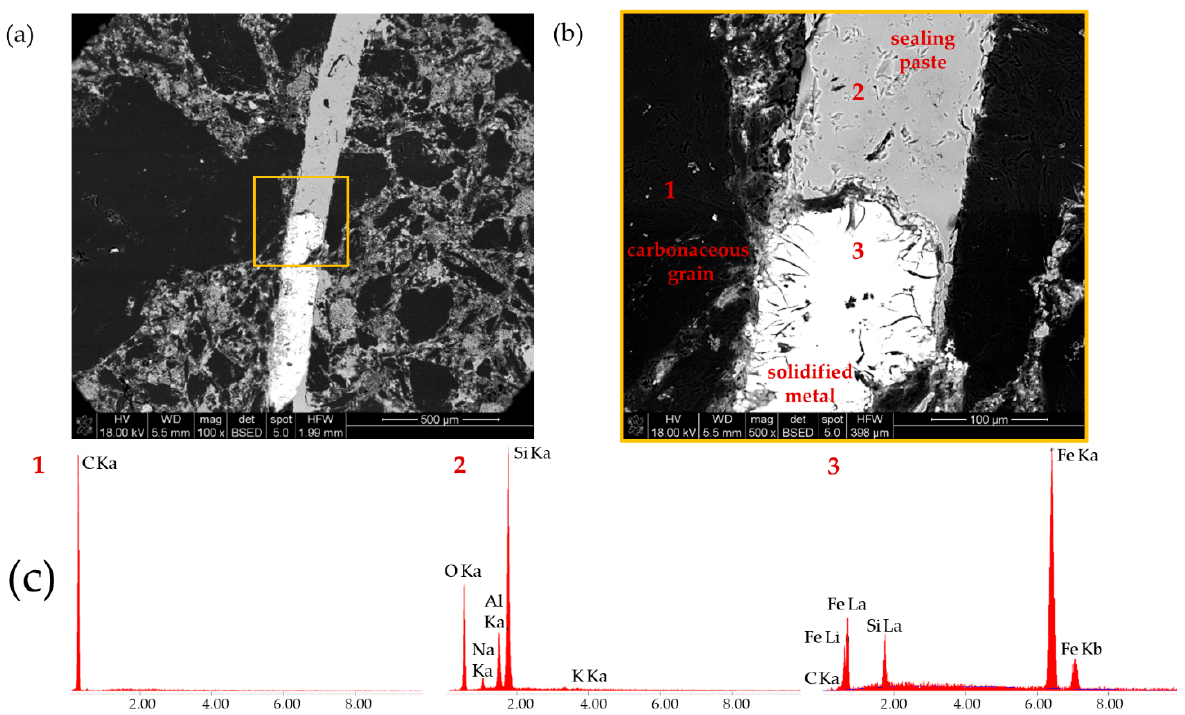
Figure 6. ( a ) SEM image of crucible sample and junction between them after metal infiltration; ( b ) SEM image of junction and solidified metal with marked points for EDS analysis; and ( c ) results of EDS point analysis.